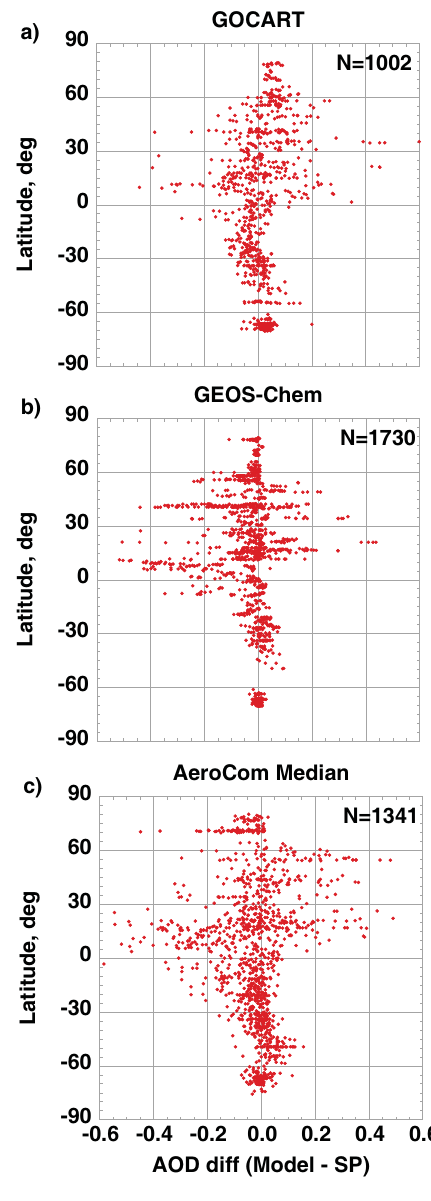
Fig. 8. Latitudinal dependence of aerosol optical depth differences between various global aerosol transport models and sunphotome-